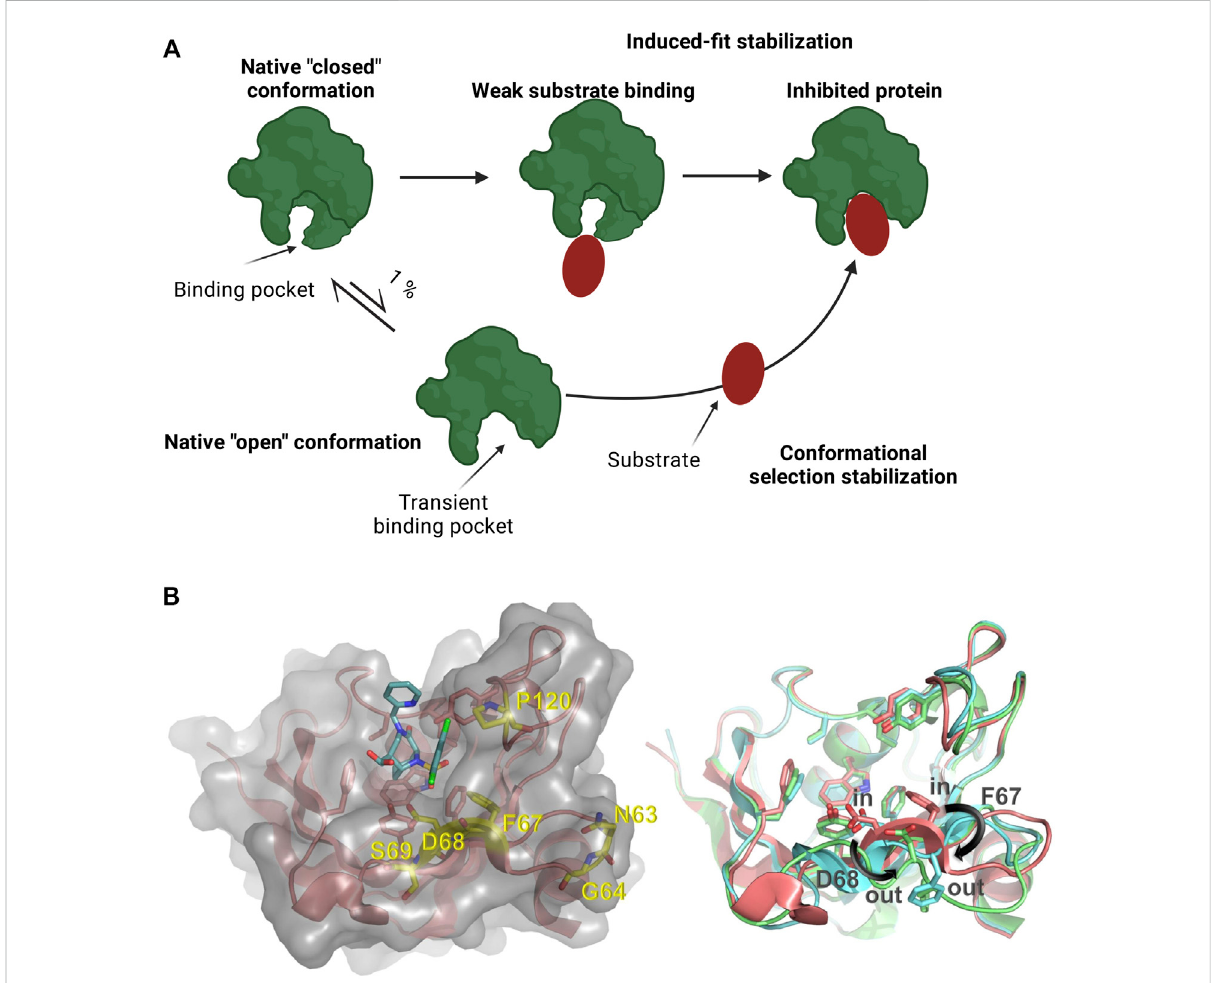
FIGURE 1 (A) Schematic representation of a protein presenting a transient binding pocket stabilized by a substrate via induced- fi t or conformational selection. Created with BioRender.com (B) Left:Structure of the FKBP51 FK1 domain (amino acids: 14 – 140) bound to FK[431] ligand ( 6 )(PDB 5OBK). The FK1 domain is depicted in salmon and important residues of the binding site are shown as sticks. The surface of the FK1 domain is indicated in lighter grey and the ligand is shown as teal sticks. Amino acids identi fi ed in the screening are shown as yellow sticks. Right: Overlay of ligand stabilized conformations of FKBP51 FK1. Ligands have been omitted for clarity. Salmon: FKBP51 FK1 domain bound to FK [431] ligand ( 6 ) (PDB 5OBK) with a F67 in /D68 in -conformation; Cyan: FKBP51 FK1 domain bound to iFit1 (PDB 4TW6) with a F67 out /D68 in -conformation;